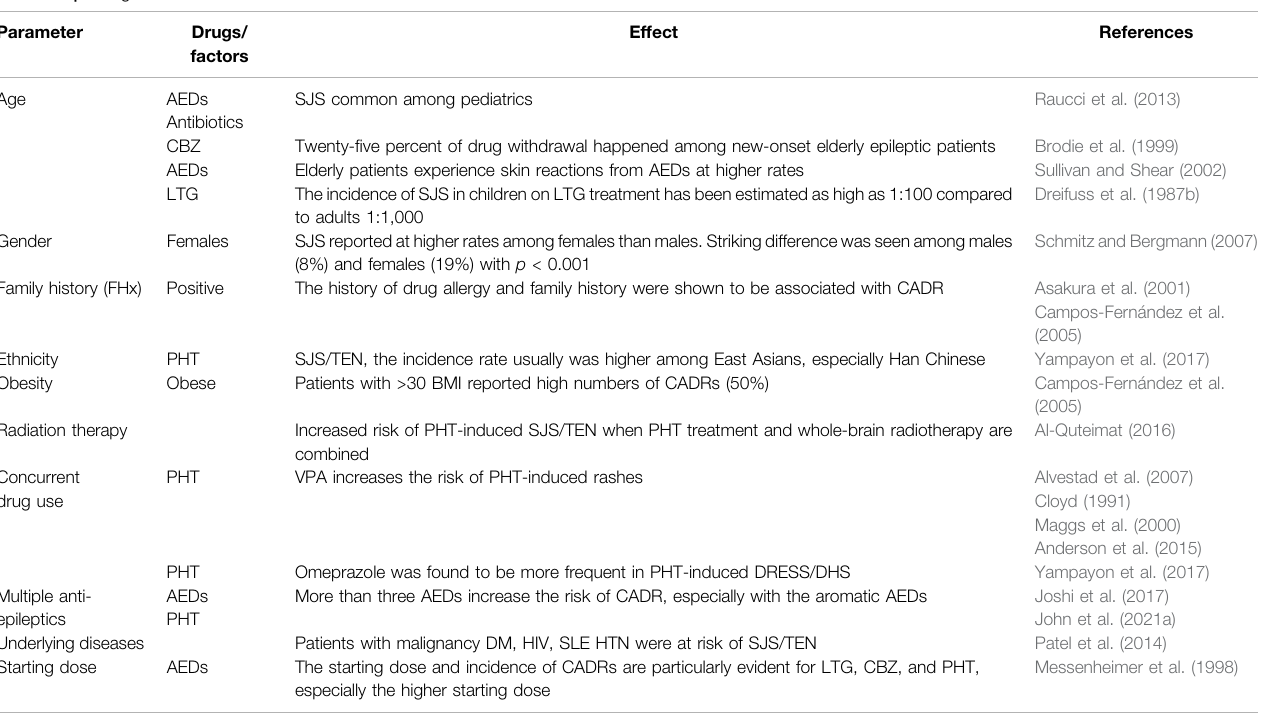
TABLE 2 | Non-genetic factors associated with